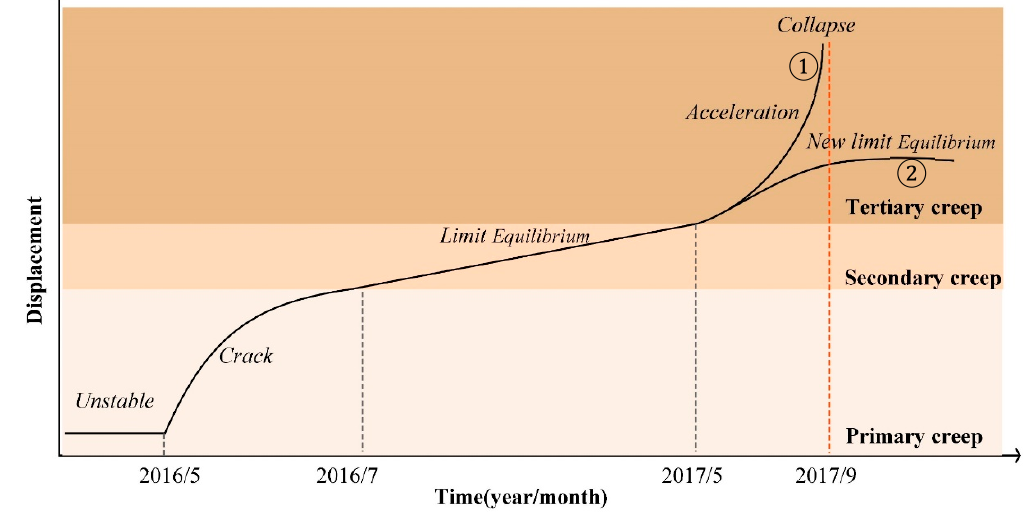
Figure 7. A concept map of Kinematics-based failure mechanisms for small-scale landslide.